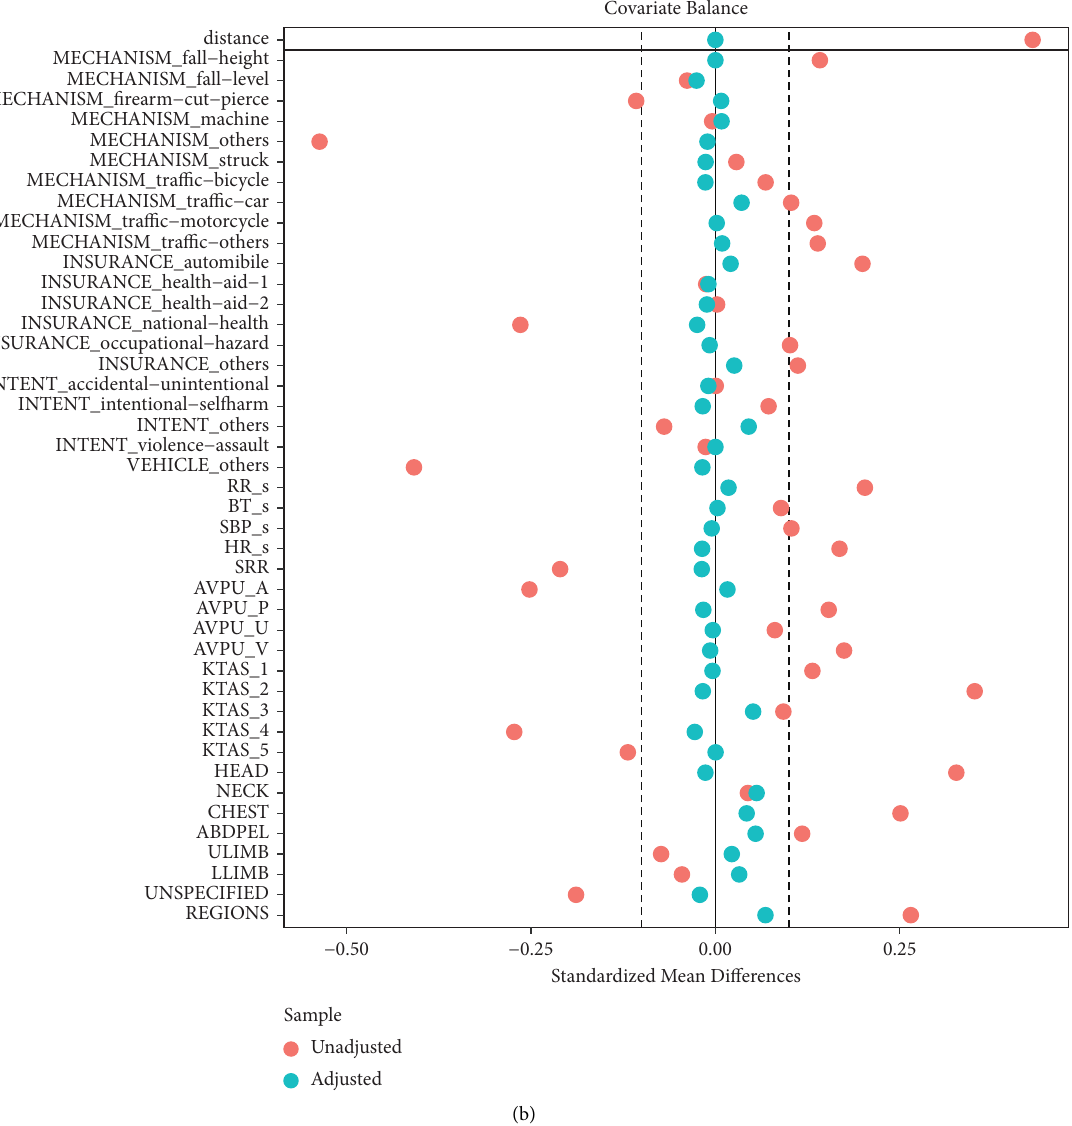
Figure 2: Graphs presenting balance statistics of the propensity matching. (a) Mirrored histogram showing the propensity score dis- tribution in the original population and matched samples of trauma patients treated in regional trauma centers and emergency medical centers. (b) Te Love plot shows changes in the standardized mean diference before (red) and after (blue) matching. EMC: emergency medical center; RTC: regional trauma center; RR: respiratory rate; BT: body temperature; SBP: systolic blood pressure; HR: heart rate; SRR: survival risk ratio of the primary diagnosis; AVPU: consciousness according to alert, verbal, painful, and unresponsive scale; KTAS: Korean Triage and Acuity Scale; ULIMB: upper limb; LLIMB: lower